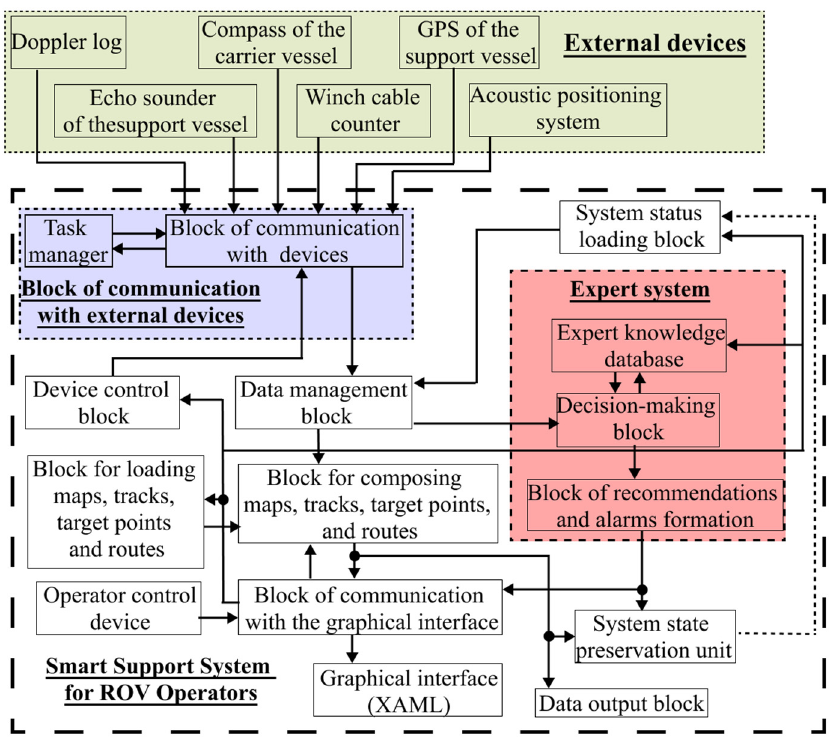
Figure 3. Block diagram showing a general architecture of the smart support system for ROV oper ‐ ators.